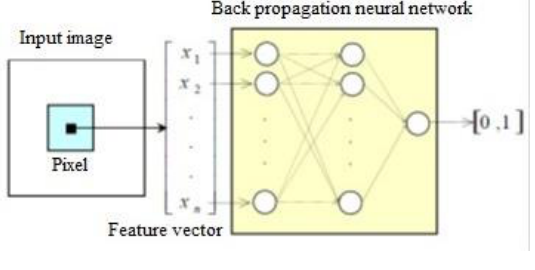
Figure 1. The structure of neural network for ship detection